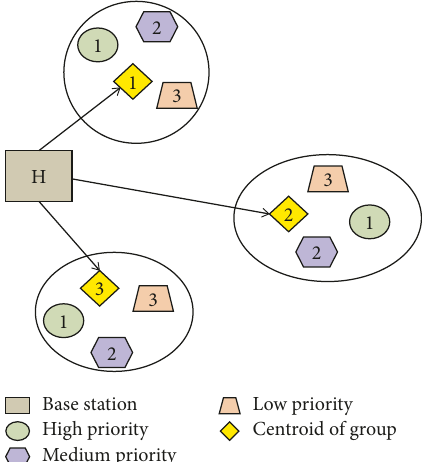
Figure 8: Proposed layout showing distances between centroids of groups and the base station.